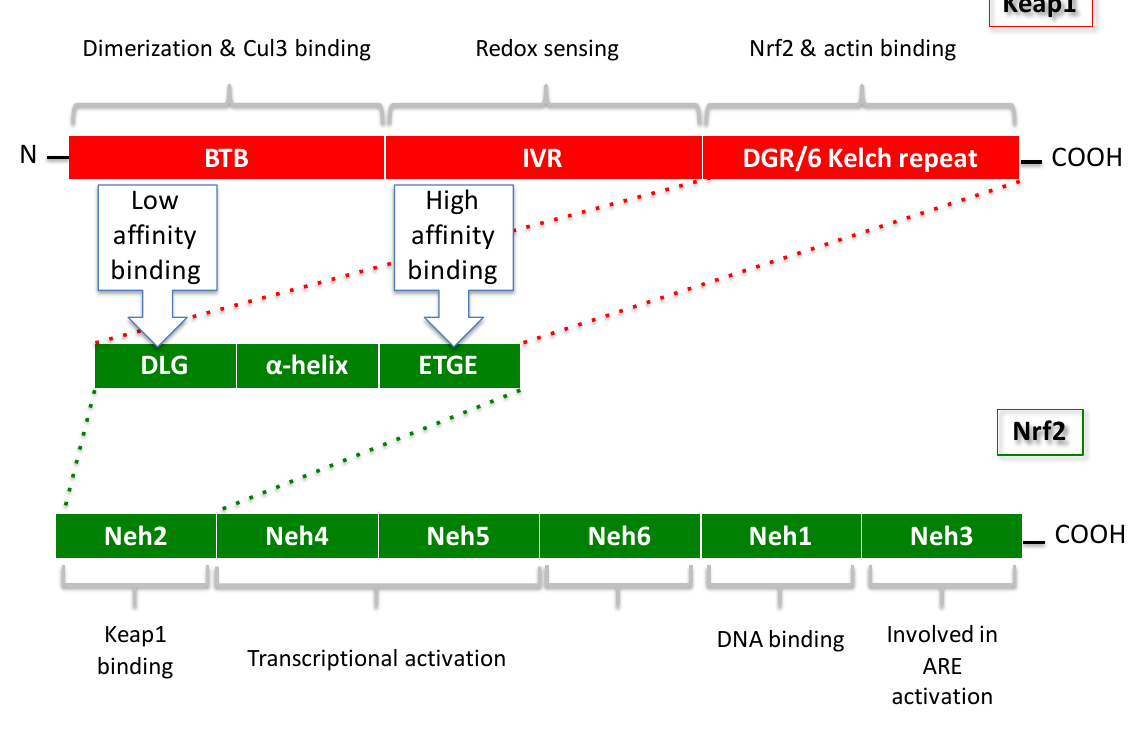
Figure 1. Structure of Keap1 and Nrf2